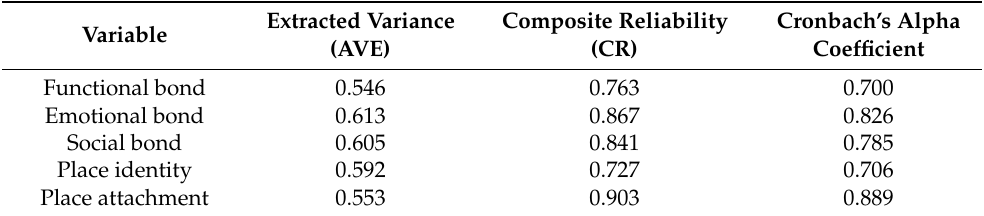
Table 1. Convergent validity and reliability of the measurement tool.